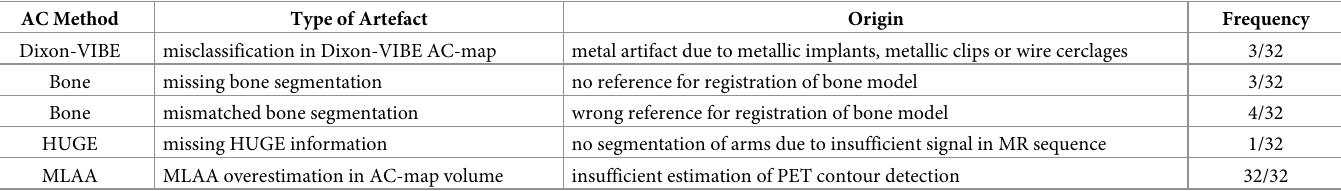
Table 1. Classification of AC-map artifacts.